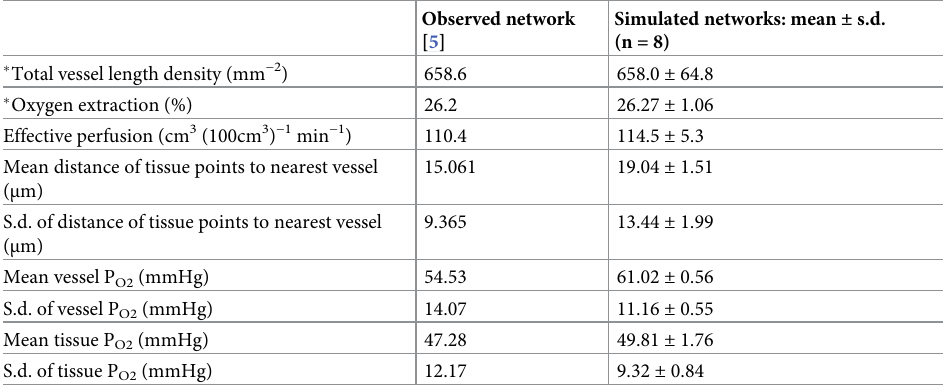
Table 2. Comparison of simulated networks with experimentally observed network properties.